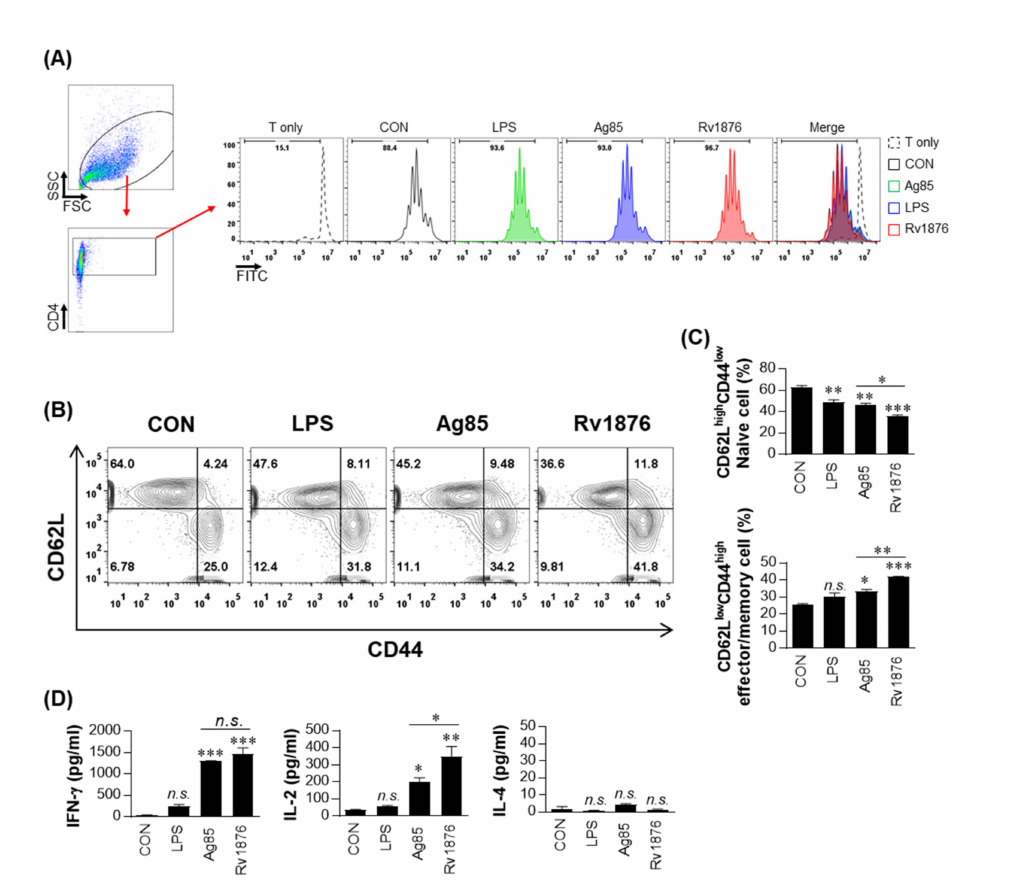
Figure 2. Rv1876-treated DCs stimulate T-cells to produce Th1 cytokines and induce the expansion of the effector/memory T-cell population. ( A , B ) Transgenic OVA-specific CD4 + T cells were isolated using MACS from OT-II mice splenocytes, stained with CFSE, and co-cultured for 96 h with DCs that had been treated with Rv1876 (10 µ g/mL), Ag85 (10 µ g/mL), or LPS (100 ng/mL) and pulsed with OVA 323–339 (1 µ g/mL) to produce OVA-specific CD4 + T cells. ( A ) The proliferation of OT-II T-cells was then assessed using flow cytometry. T cells alone and T cells co-cultured with untreated DCs served as the controls. Representative histograms from three independent experiments are shown. ( B – D ) DCs were treated with Rv1876 (10 µ g/mL) or LPS (100 ng/mL) and cocultured for 3 days with T cells from BCG-infected mice at DC to T cell ratios of 1:10. Splenocytes were stained with anti-CD4, anti-CD62L, and anti-CD44 mAbs. ( B ) Bar graphs show CD62L low CD44 high T cells or CD62L high CD44 low T cell populations among the spleen cells. ( C ) A histogram is shown for the gating of the labeled T cells. All data are expressed as the mean ± standard deviation (SD); * p < 0.05, * p < 0.01, or *** p < 0.001 for treated samples compared to non-treated DCs co-cultured with CD4 + T cells; n.s, not significant, as determined by one-way ANOVA. ( D ) Culture supernatants were harvested after 96 h, and the IFN- γ , IL-2, and IL-4 levels were determined using ELISAs. All data are expressed as the mean ± standard deviation (SD); * p < 0.05, * p < 0.01, or *** p < 0.001 for treated samples compared to non-treated DCs co-cultured with CD4 + T cells; n.s., not significant, as determined by one-way